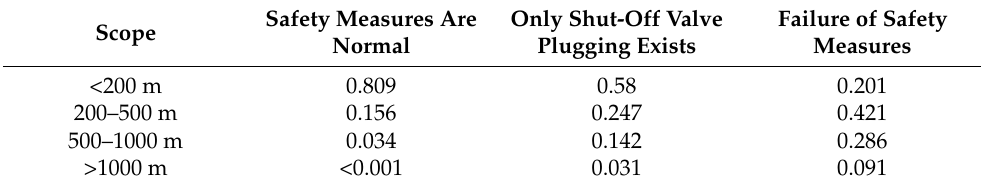
Table 4. Liquid ammonia leakage range